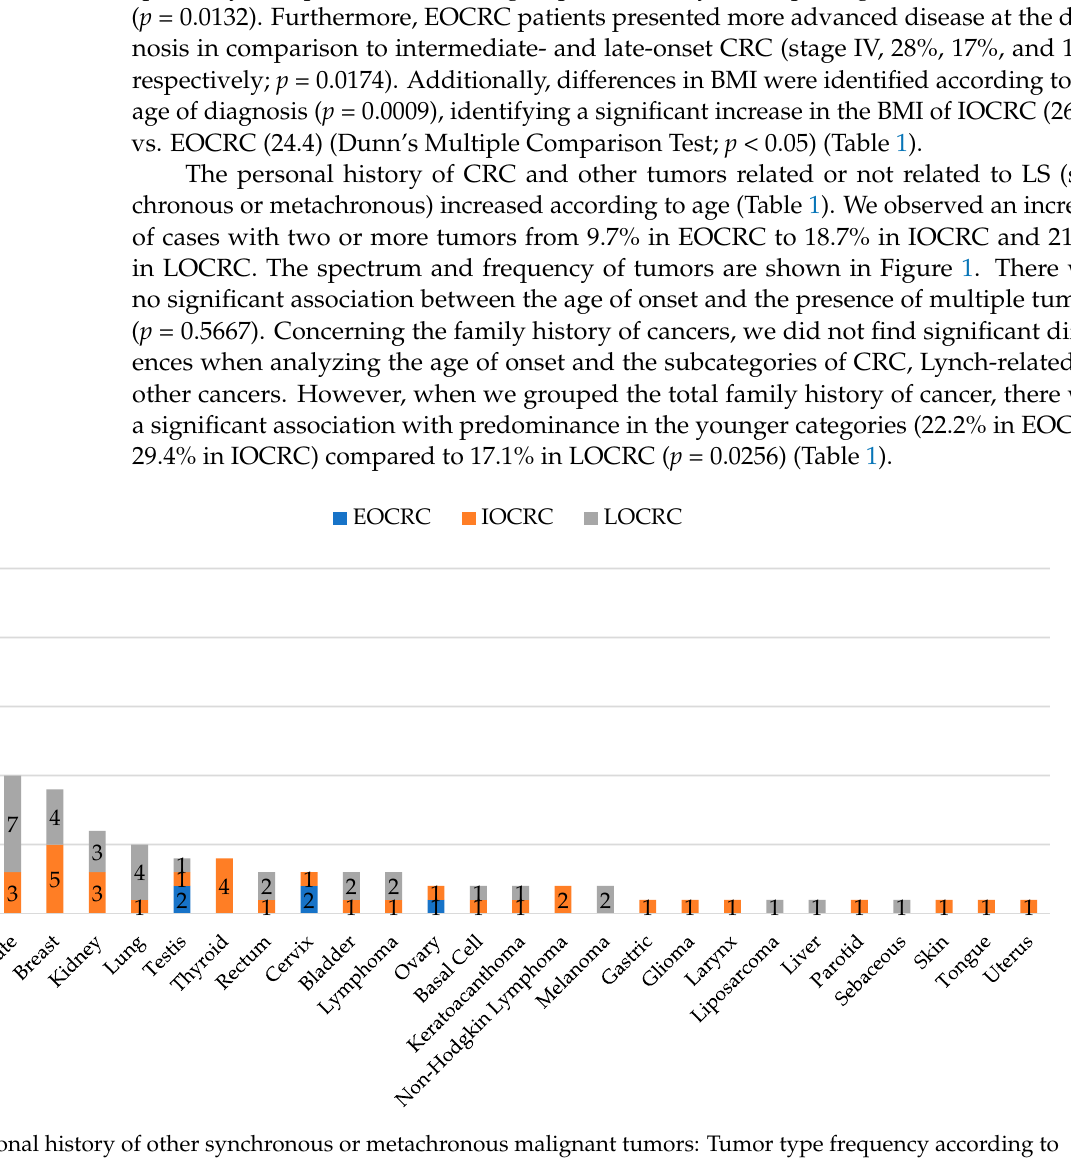
Table 2. Colorectal diagnosis trends according to age over the years.